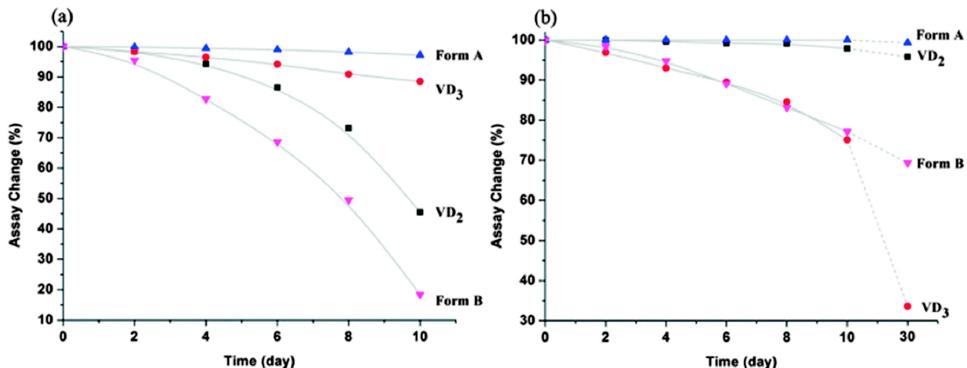
Figure 44. Change in vitamin D 3 assay during storage at ( a ) 23 °C with an illuminance of 5000 lx and ( b ) 40 °C/75%RH for cocrystal A and B compared with starting materials. Adapted with permission